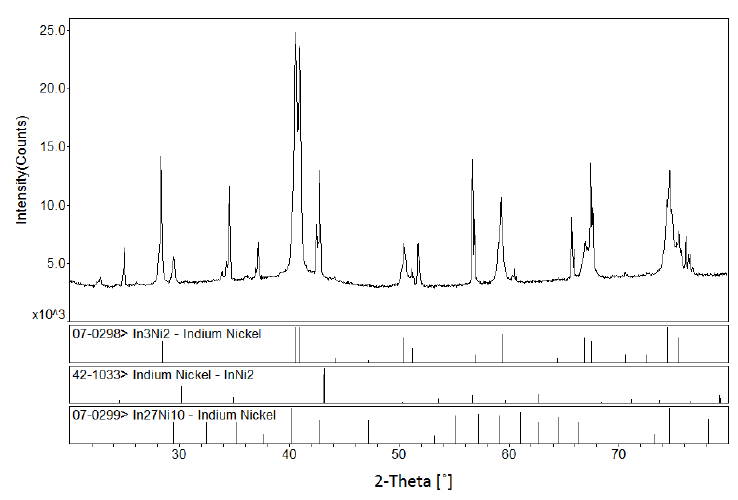
Materials 2020 , 13 , x FOR PEER REVIEW Figure 24. The XRD patterns of sample Ni 2 − x Co x In 3 (x = 0.200) at 490 K. Figure 24. The XRD patterns of sample Ni 2 − x Co x In 3 (x = 0.200) at 490 K.